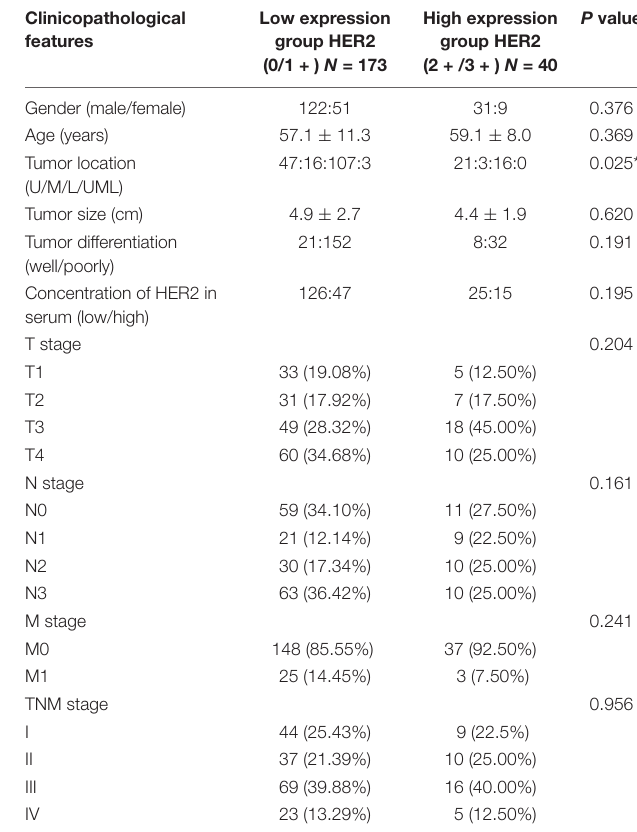
TABLE 1 | Clinicopathological characteristics of all patients separated by serum concentration of HER2. Clinicopathogical features